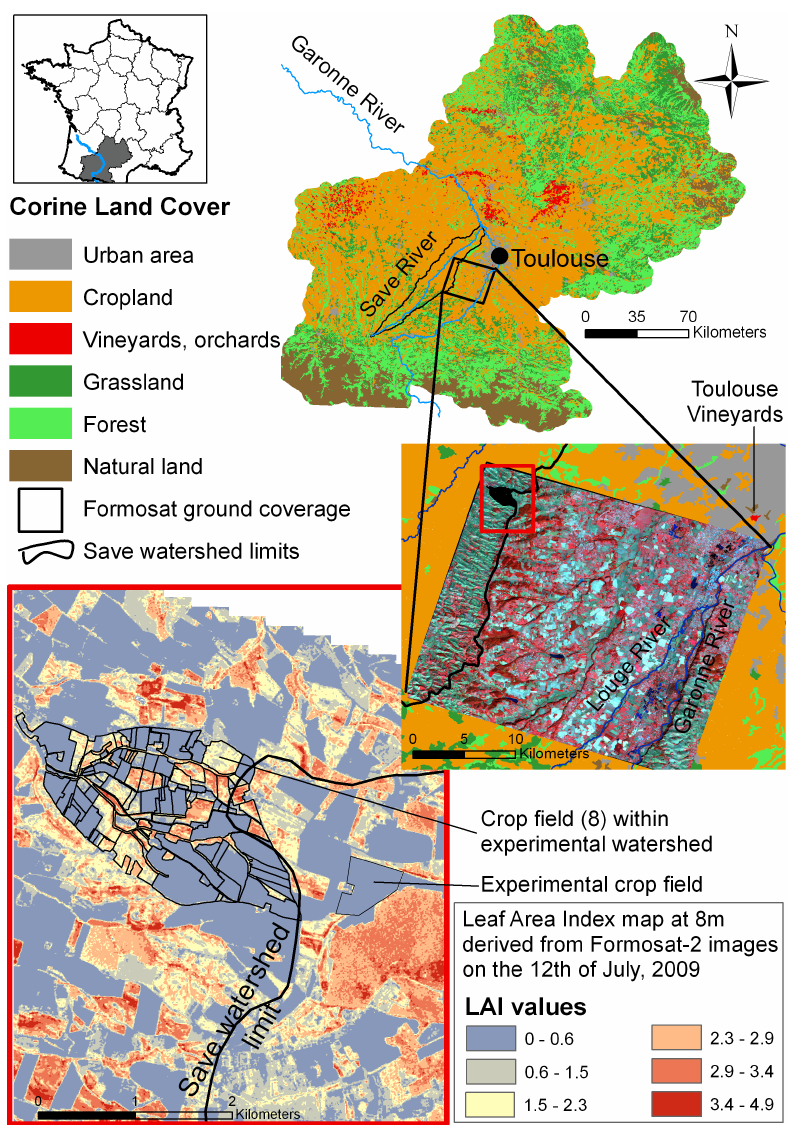
Figure 1. Location of the catchment area studied. The Auradé catchment comprises 101 cultivated crop fields. The cropping pattern is a rotation of winter wheat and sunflower. The Formosat-2 series ground coverage is representative of the cropland area characterizing the region around Toulouse. Atmospheric turbulent fluxes, ground vegetation dynamics, and agro-meteorological measurements have been performed in the experimental crop field near the study site since 2005. A detail of the LAI map derived from the Formosat-2 image for 12 July 2009 shows the high variability of the LAI within the sunflower plots (still active at that period of the year), whereas other areas are close to zero, corresponding to winter wheat having reached the senescence